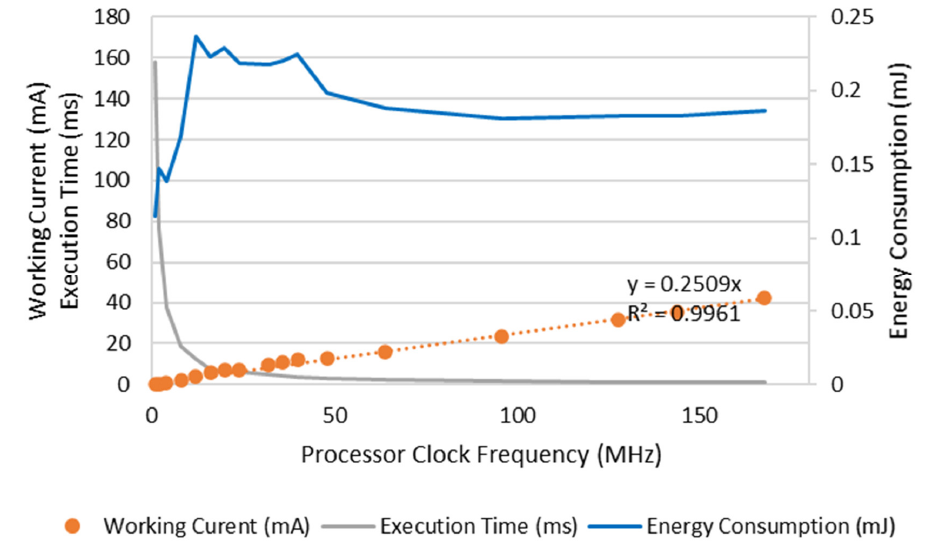
Figure 6. The relation between the energy consumption of the microcontroller itself, the processor clock frequency, and the working current.